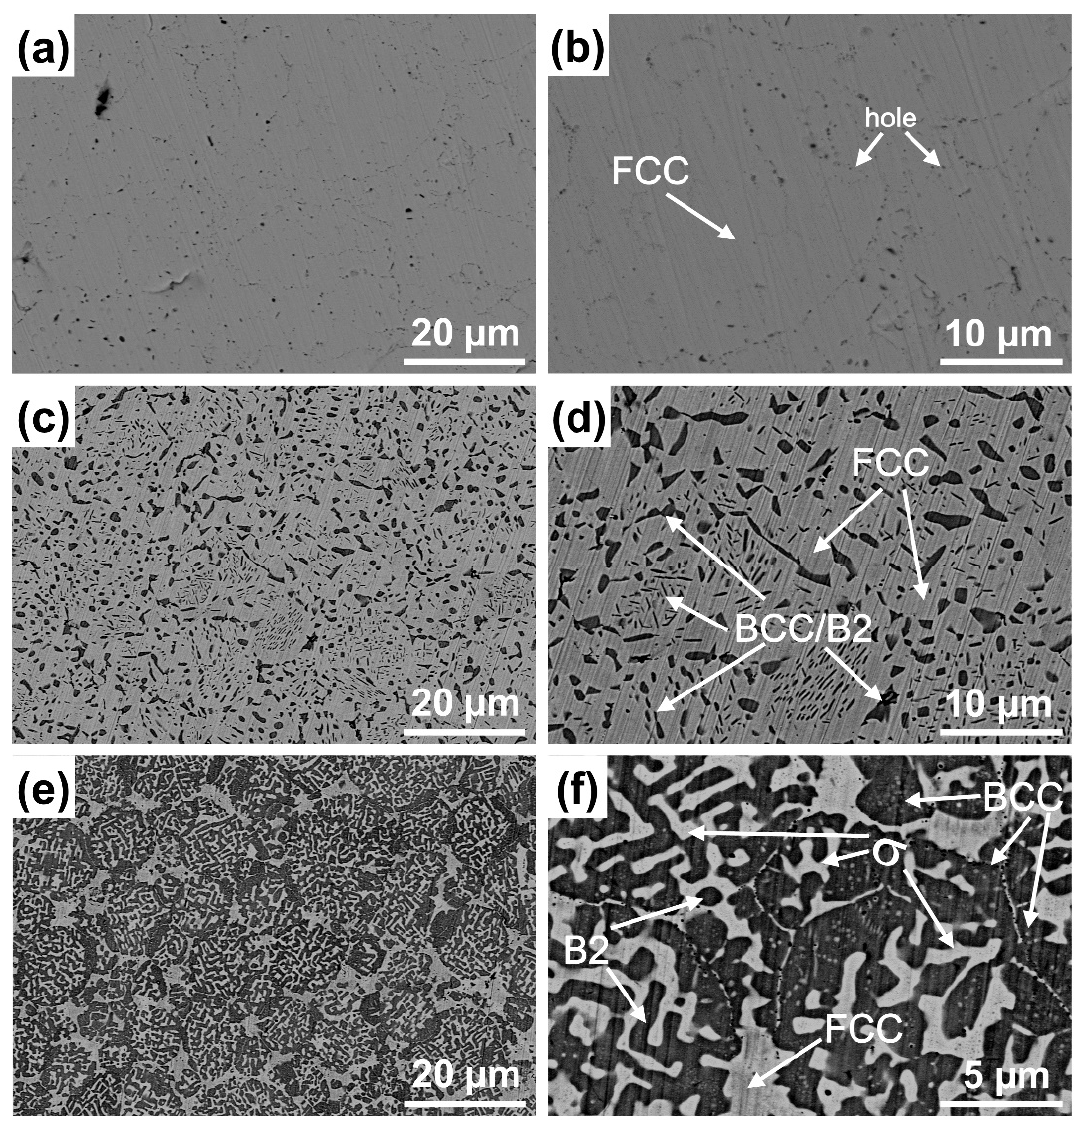
Figure 2. The SEM back scattering electron images of AlxCoCrFeNi HEAs. ( a ) and ( b ): Al0.2CoCrFeNi; ( c ) and ( d ): Al0.5CoCrFeNi; ( e ) and ( f ): AlCoCrFeNi. Table 1. EDS analysis results of AlxCoCrFeNi HEA (unit: at %), see Figure 2 for the specific phases.